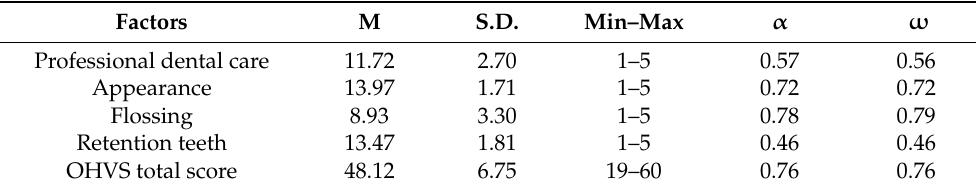
Table 2. Means, standard deviations, and reliabilities ( n = 869).